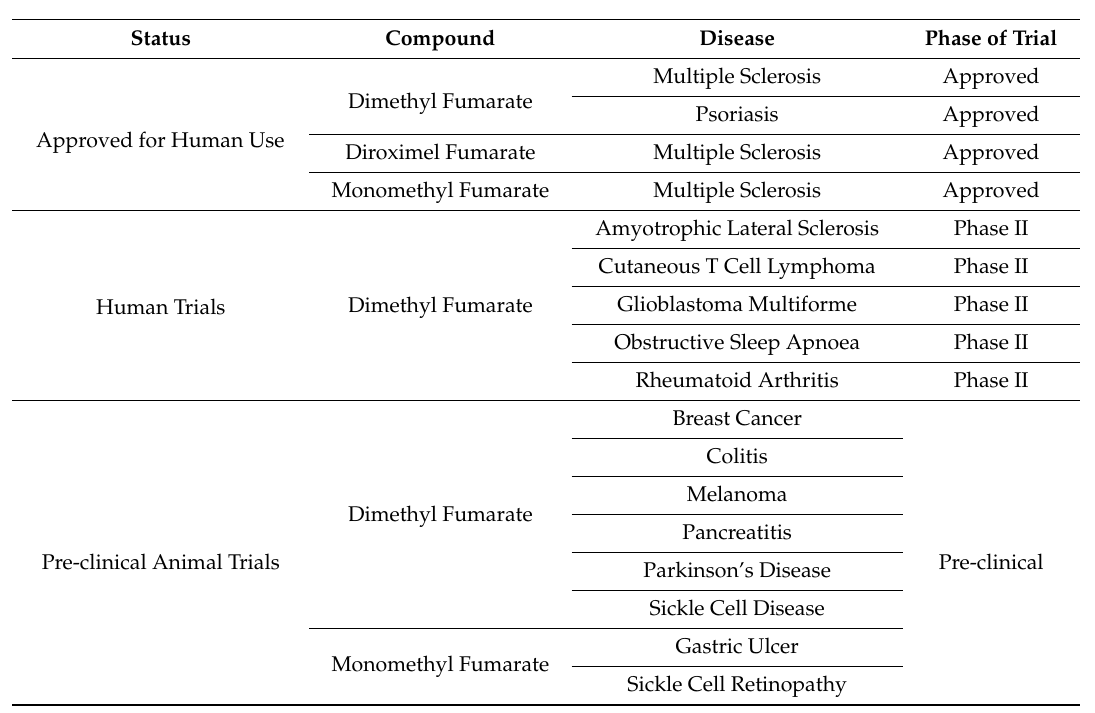
Table 1. Summary of fumaric acid esters either approved for human use, previously tested or currently examined in human / animal